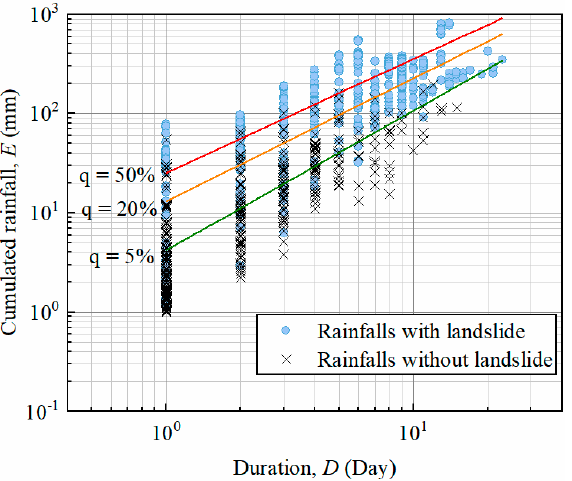
Figure 5. Double-log plot of cumulative rainfall E versus time D for landslides, conditions triggering landslides, and corresponding 5%, 20%, and 50% E–D thresholds in Guangzhou.